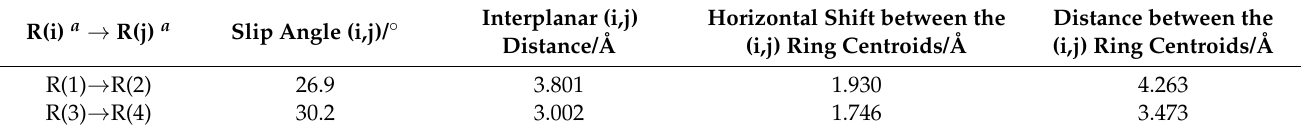
Table 2. Structural parameters of π − π stacking interaction.